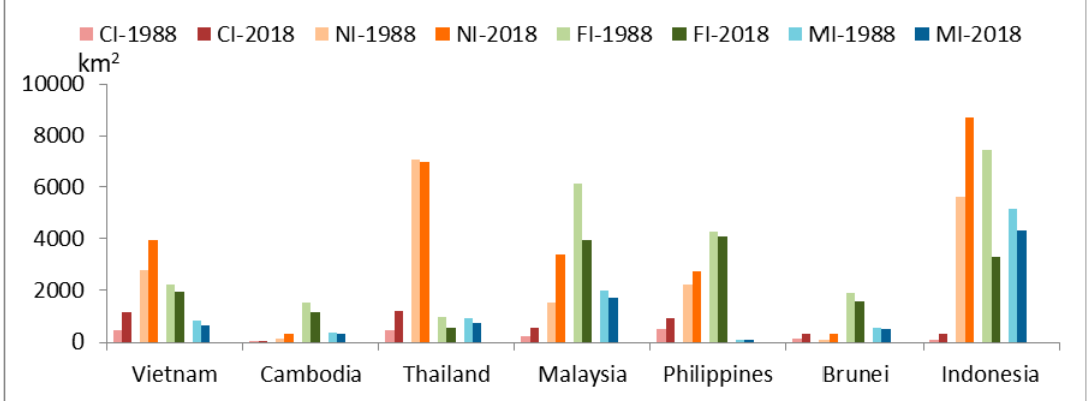
Figure 5. Area of the land use types in each country.